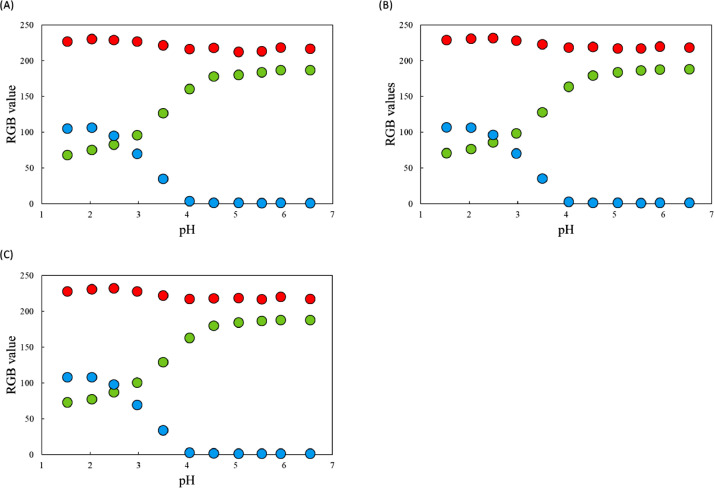
RGB values of the ROI in Fig. 1. The ROI was set to (A)1024 × 822 pixels (B)100 × 100 pixels, and (c) 10 × 10 pixels.